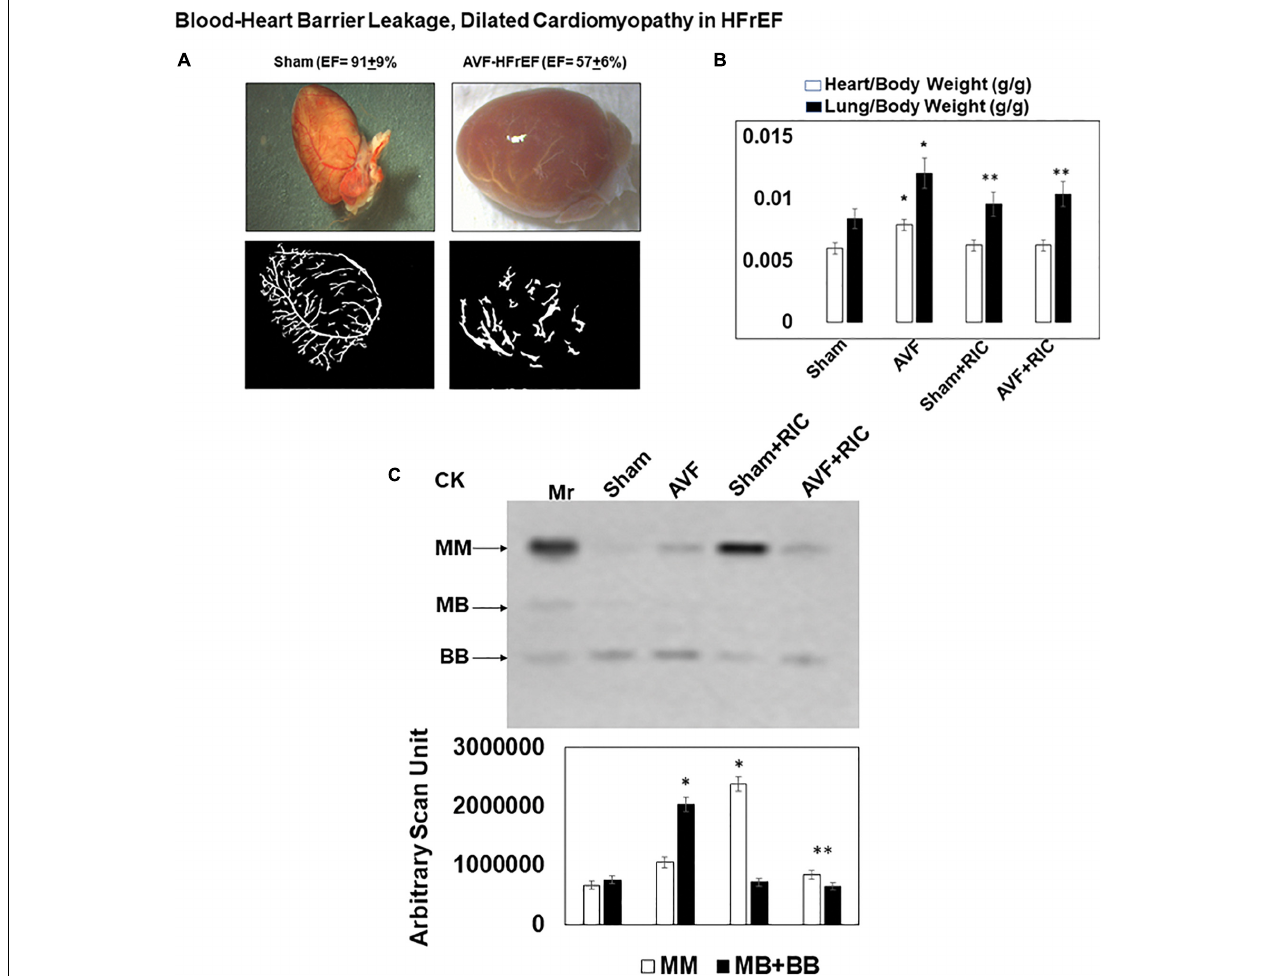
FIGURE 2 | (A) Morphology of a sham and cardiopulmonary heart failure (CHF)-AVF heart: the shape of the heart normally is a spindle shape; however, in CHF, it takes a global shape. The vascular density is decreased in CHF, and the vessels are more dilated and leakier as compared to the normal heart. This suggested disruption of blood-heart barrier (BHB) and dilated cardiomyopathy. (B) The heart and lung weight of sham and AVF mice treated with and without the hind-limb remote ischemic condition (RIC). The heart-lung weights were increased in CHF indicative of congestive HF. Bar graphs with ± SD are representative of n = 5–8. (C) The in-gel creatine kinase (CK) activity (upper panel). Both the skeletal muscle and cardiac and neuronal CKs were increased in AVF and RIC. Interestingly the RIC mitigated the cardiac damage. Bar graphs of relative scan units with ± SD are representative of n = 5–8. * and ** indicate significant difference ( p < 0.05) either to “sham without RIC” or to “0”